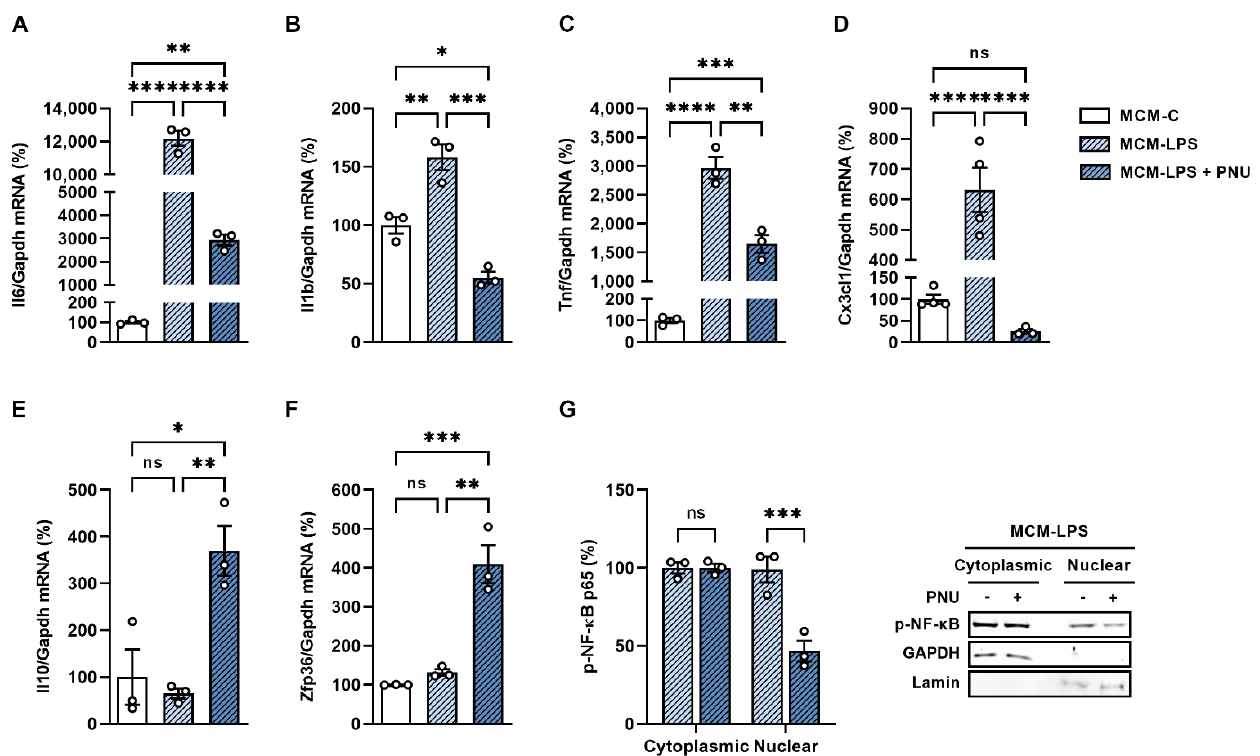
Figure 4. Activation of α 7nAchR prevents inflammation induced by microglial conditioned medium and increases the expression of Il-10 and TTP in neurons. Immortalized mHypoA-2/29 neuronal cells were incubated for 6 h with MCM-C or MCM-LPS. A stimulus with the selective α 7nAchR agonist PNU-282987 (1 µ M) was administered 15 min before and 3 h after the start of conditioned medium treatment. After treatment, ( A ) IL-6, ( B ) IL-1 β , ( C ) TNF- α , ( D ) CX3CL1, ( E ) IL-10, and ( F ) Zfp36 mRNA expression was evaluated by RTq-PCR and ( G ) NF- κ B phosphorylation was evaluated by western blot. * p < 0.05, ** p < 0.01, *** p < 0.001, **** p < 0.0001, n = 3 – 4.